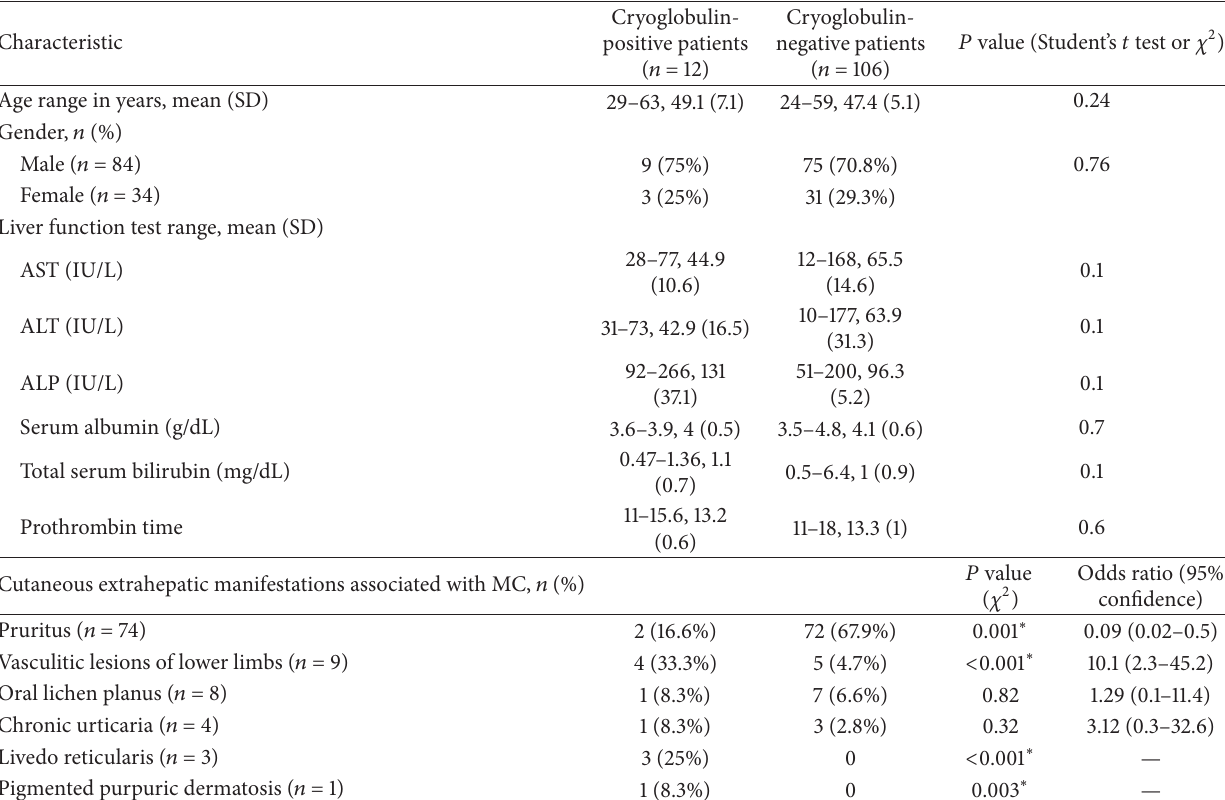
Table 2: Relationship between cryoglobulin-positivity and patients’